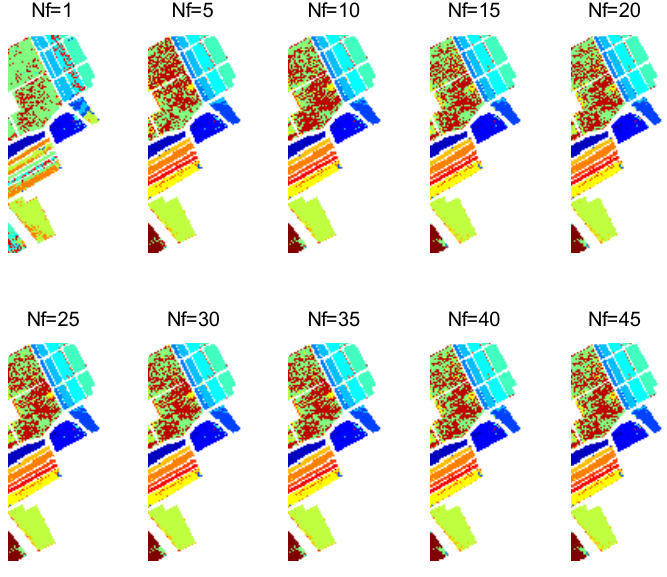
and different (cid:13) for Salinas dataset 3 = 10 4